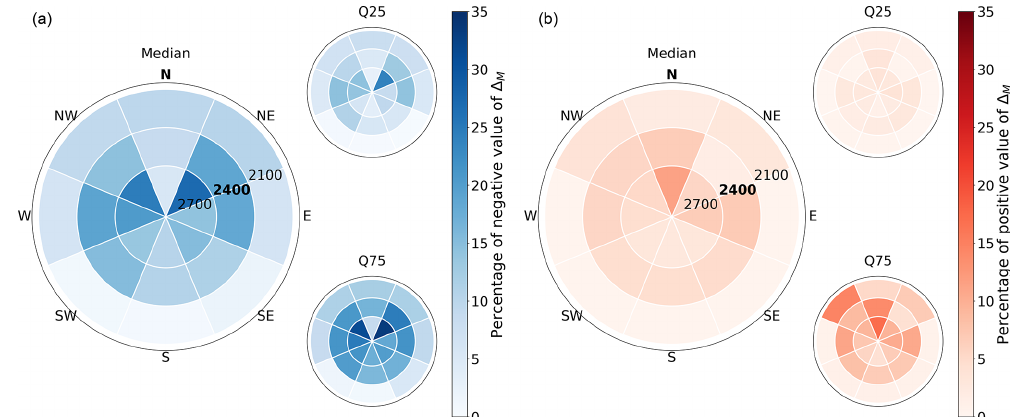
Figure 7. Number of days with (a) a more stable and (b) a less stable snowpack when contaminated with dust for each of the eight slope aspects and for three different elevations: 2100, 2400 and 2700m. The values are calculated from 5 March to 9 April 2018. The bold labels (2400m north) correspond to the configuration of Sect. 3.2.1 and 3.2.2. The biggest pie plot corresponds to the median of ensemble members and the small pie plots to the first (Q25) and third (Q75) quartiles of ensemble members.